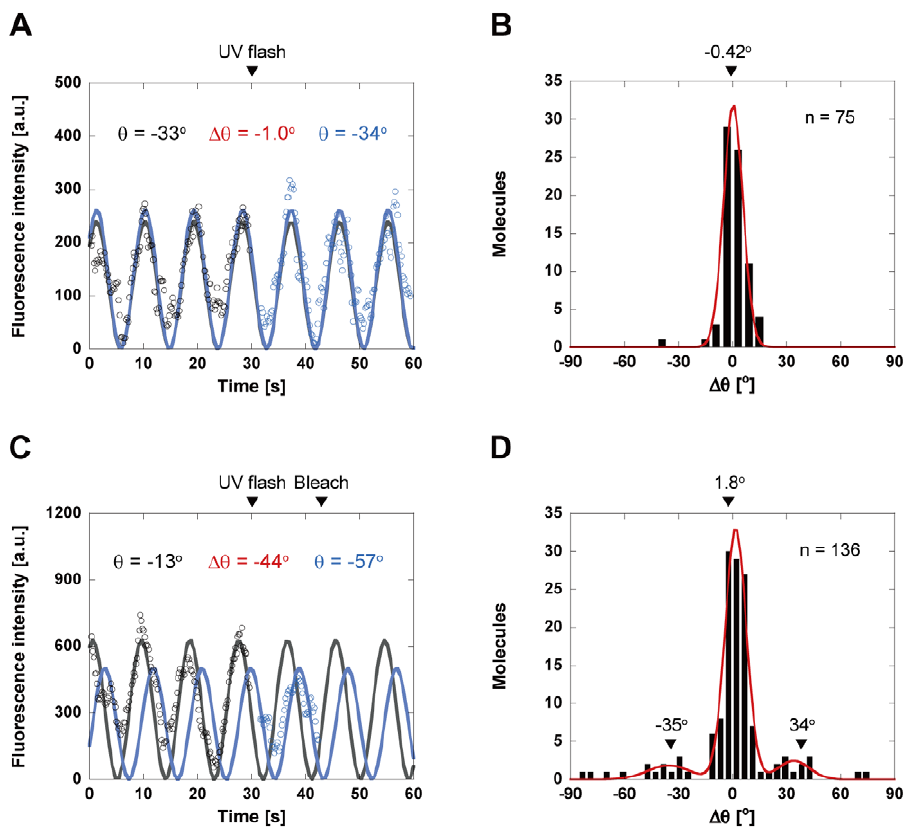
Figure 4. Time trajectories of the fluorescence intensity and calculated fluorophore angles. ( A , C ) Time trajectory of BSR intensity in the absence ( A ) and presence of caged ATP ( C ). The UV flash occurred at 30 s ( arrow ). The trajectories of BSR intensities after subtracting the background signals were averaged over every five frames, and fitted to a quadratic cosine function ( solid lines ). Black , fluorescence intensity before UV flash; blue , fluorescence intensity after UV flash. ( B , D ) Distributions of D h in the absence ( B ) and presence of caged ATP ( D ). Positive angle , angular displacement measured counterclockwise; negative angle , angular displacement measured clockwise. In the absence of caged ATP ( B ), the distribution corresponded to a Gaussian distribution with a peak of 2 0.42 u . In the presence of caged ATP ( D ), the distribution can be fitted by a sum of three Gaussian functions, with peaks of 1.8 u , 34 u , and 2 35 u .